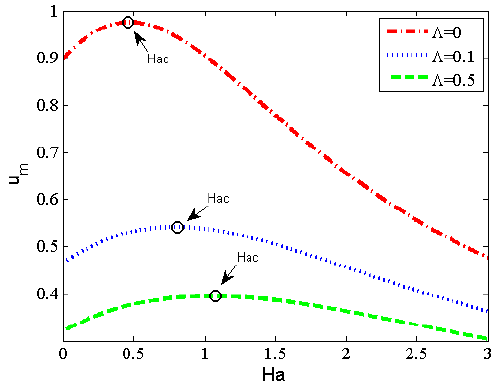
Figure 5. Variations of the average velocity with Ha for different magnitudes of Λ ( S = 1).